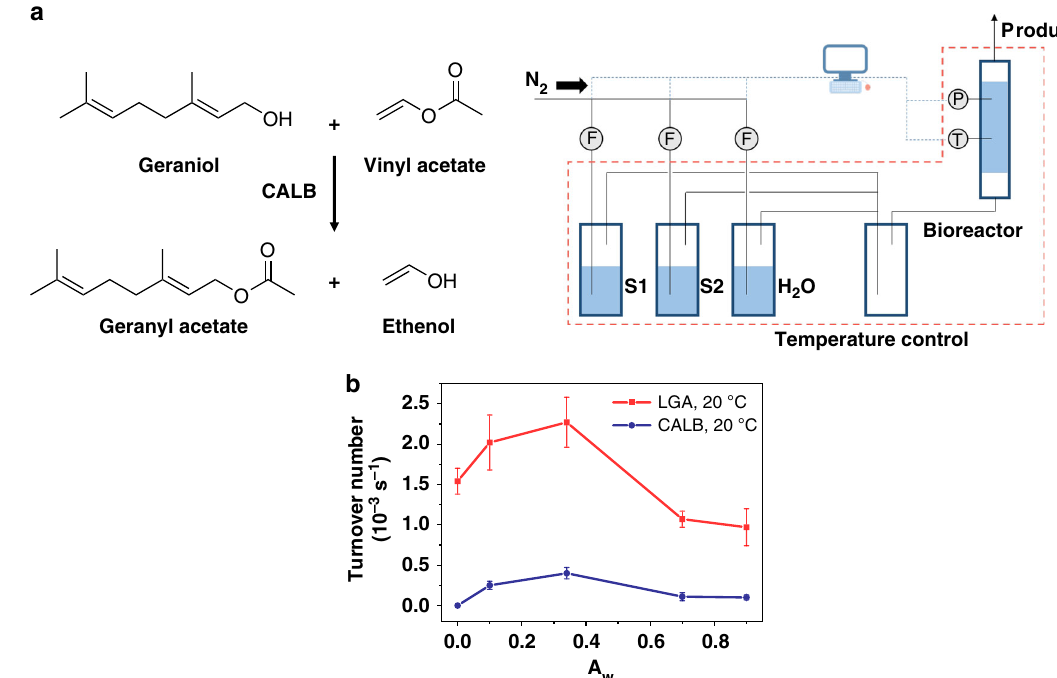
Fig. 4 Experimental setup and activity test for transesteri fi cation. a Transesteri fi cation of geraniol and vinyl acetate catalyzed by CALB, and experimental setup for gaseous enzymatic catalysis. b the effects of water activity on the turnover numbers of LGA and CALB at 20 °C. Error bars represent the s.d. of three replicates. Source data are provided as a Source Data fi le